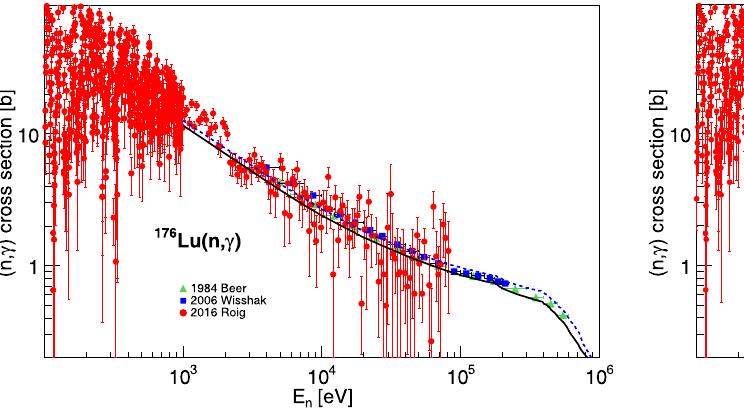
Fig. 11. 176 Lu( n , g ) 177 Lu cross-section as function of the incident neutron energy E . The full red line show the predictions obtained using microscopic inputs for both the NLD and GSF. The full black line shows the predictions obtained adding on top of the defaut prescriptions a low energy M1 strength. In both cases G norm =1.